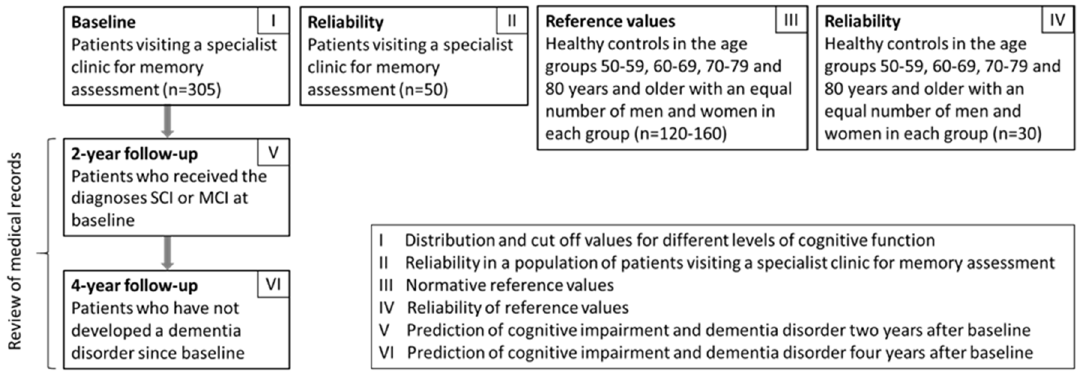
Figure 3. Overview of planned and initiated UDDGait-studies I–VI.